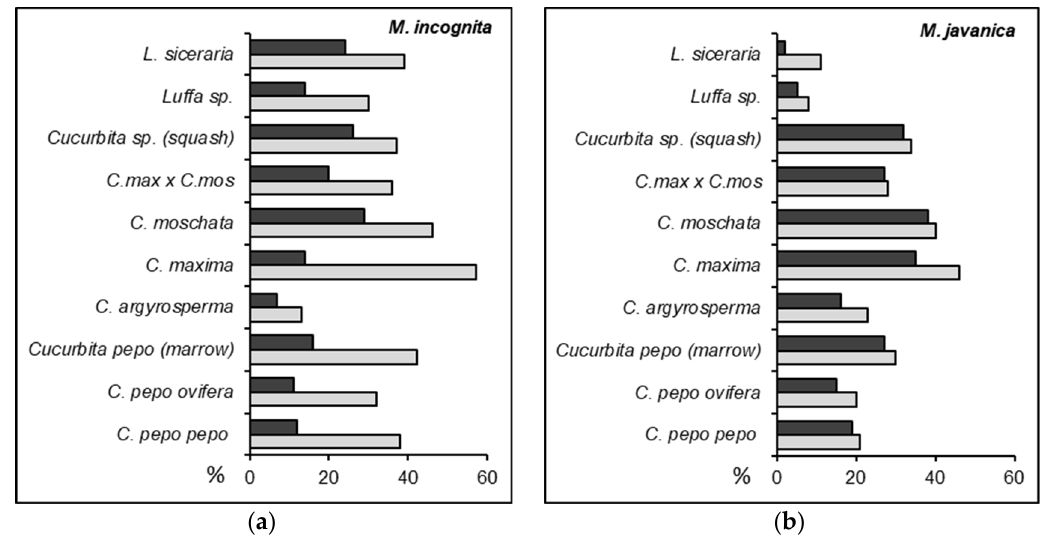
Figure 1. Parasitic success (egg masses × 100 / 250 J2 inoculum) (dark grey) and pathogenic potential (total galls × 100 / 250 J2 inoculum) (light grey) of Meloidogyne incognita ( a ) and M. javanica ( b ) on several cucurbitaceous genotypes.